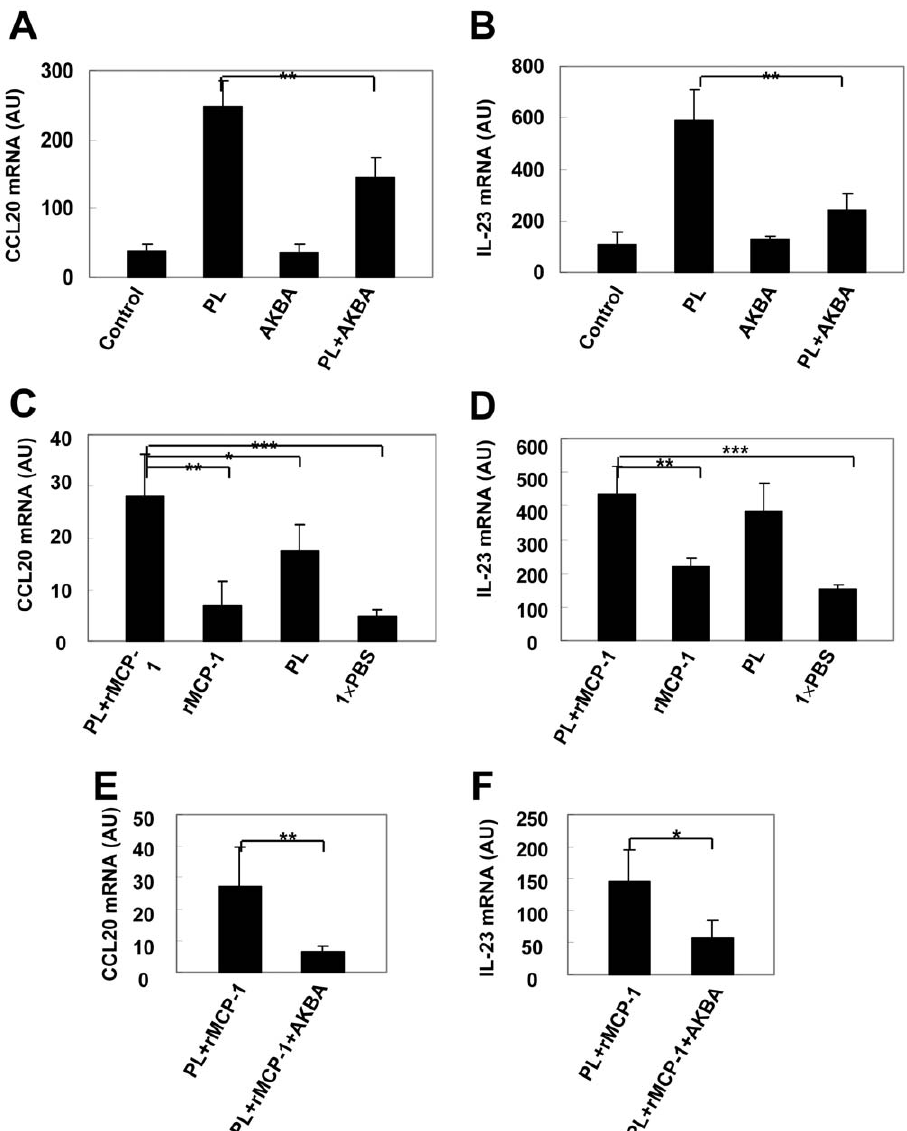
Figure 5. Induction of NF- k B-dependent expression of CCL20 and IL-23 by PL in vitro and in vivo. ( A, B ) Real-time PCR for CCL20 and IL- 23 in RNA samples prepared from macrophages with indicated treatment. Ears of WT C57BL/6J mice were injected intradermally with 1.5 m g PL and 30 ng rMCP-1, 30 ng rMCP-1, 1.5 m g PL and 30 ng rMCP-1 and 10 mol/L AKBA or 30 m l 1 6 PBS alone. ( C, D ) Six hours after injection of PL and rMCP-1, rMCP-1 or PL alone, real-time PCR for CCL20 and IL-23 was performed. ( E, F ) Six hours after injection of PL and rMCP-1 or PL and rMCP-1 and AKBA, real-time PCR for CCL20 and IL-23 was carried out. * p , 0.05, ** p , 0.01, *** p , 0.001, Student’s t test.